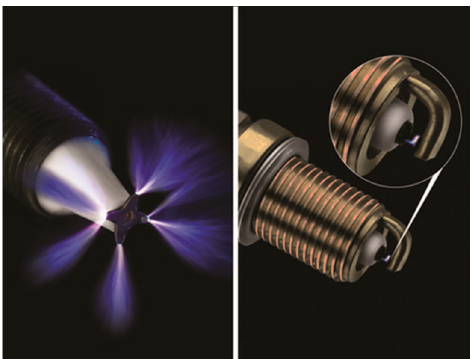
Figure 13. Difference between ACIS ( left ) and conventional spark plug ( right ) [419].